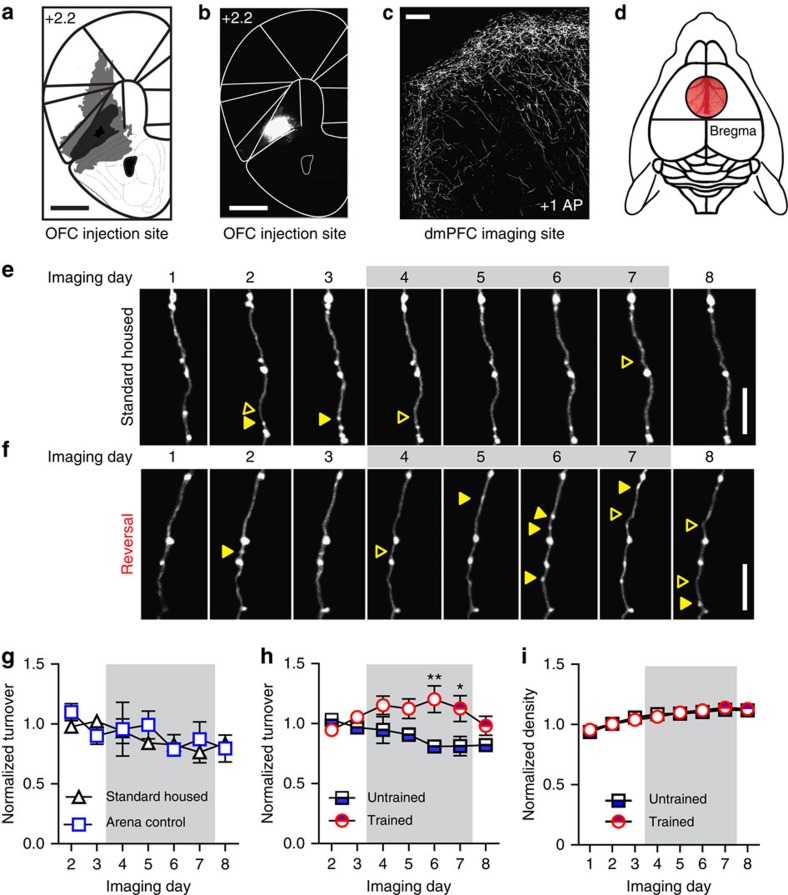
Rule training enhances OFC bouton turnover.(a) Schematic showing the extent of viral labelling at injection site in the OFC in all experimental mice (n=35). Black indicates the minimum expression and light grey is the maximum expression. Medium grey shows a representative example of labelling. (b,c) Representative image of viral labelling at the injection site in OFC (b) and of axonal projections to the upper layers of contralateral dmPFC (c). (d) Schematic of cranial window implant over dmPFC. (e,f) Representative in vivo two-photon images of axons of a ‘standard-housed' (e) and a ‘reversal' trained (f) subject across imaging sessions. Open and closed arrowheads indicate bouton gain and loss, respectively. (g) Bouton turnover did not differ between the ‘standard-housed' (n=10) and ‘arena control' (n=8) groups across imaging sessions (group: F(1,16)=0.35, P=0.56; time: F(6,96)=1.70, P=0.13; interaction: F(6,96)=0.56, P=0.76). (h) The ‘trained' group (n=17 mice) had significantly higher bouton turnover following the odour discrimination (day 6) and recall/reversal (day 7) sessions compared with the ‘untrained' group (n=18 mice; group: F(1,33)=14.59, P=0.0006; time: F(6,198)=0.87, P=0.52; interaction: F(6,198)=2.38, P=0.03). (i) Density did not differ between ‘untrained' and ‘trained' groups (group: F(1,33)=0.06, P=0.81; time: F(7,231)=63.34, P<0.0001; interaction: F(7,231)=0.88, P=0.52). Groups in g–i were compared using two-way repeated measures analysis of variance and Bonferroni post hoc tests. Data from each mouse were normalized to the average of baseline sessions and are presented as mean±s.e.m. in g–i. Scale bars, (a,b) 1 mm; (c) 100 μm; (e,f) 10 μm. *P<0.05, **P<0.01.